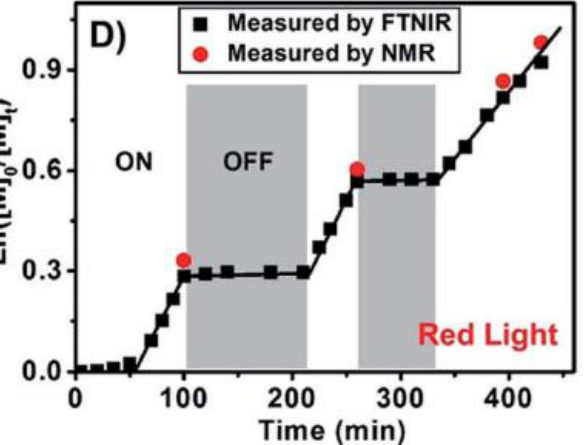
Figure 6. Temporal control of PET-RAFT technique. Reproduced with permission from ref. [31].